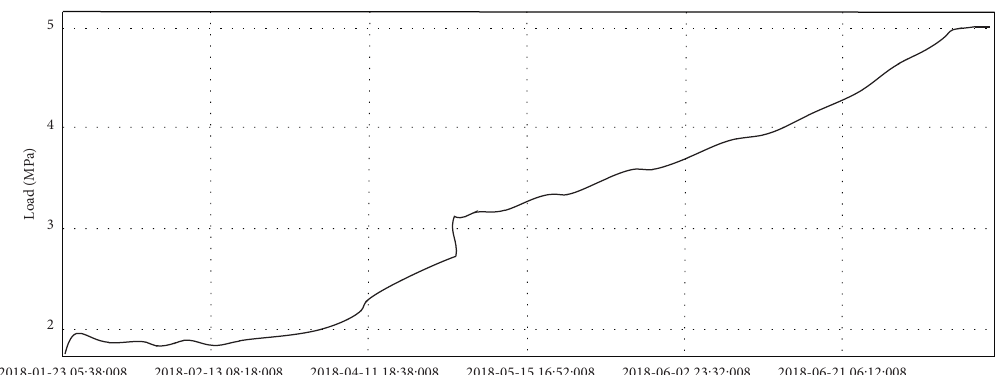
Figure 9: Measuring curve of working resistance of advanced unit in gangue transport roadway of the working face.